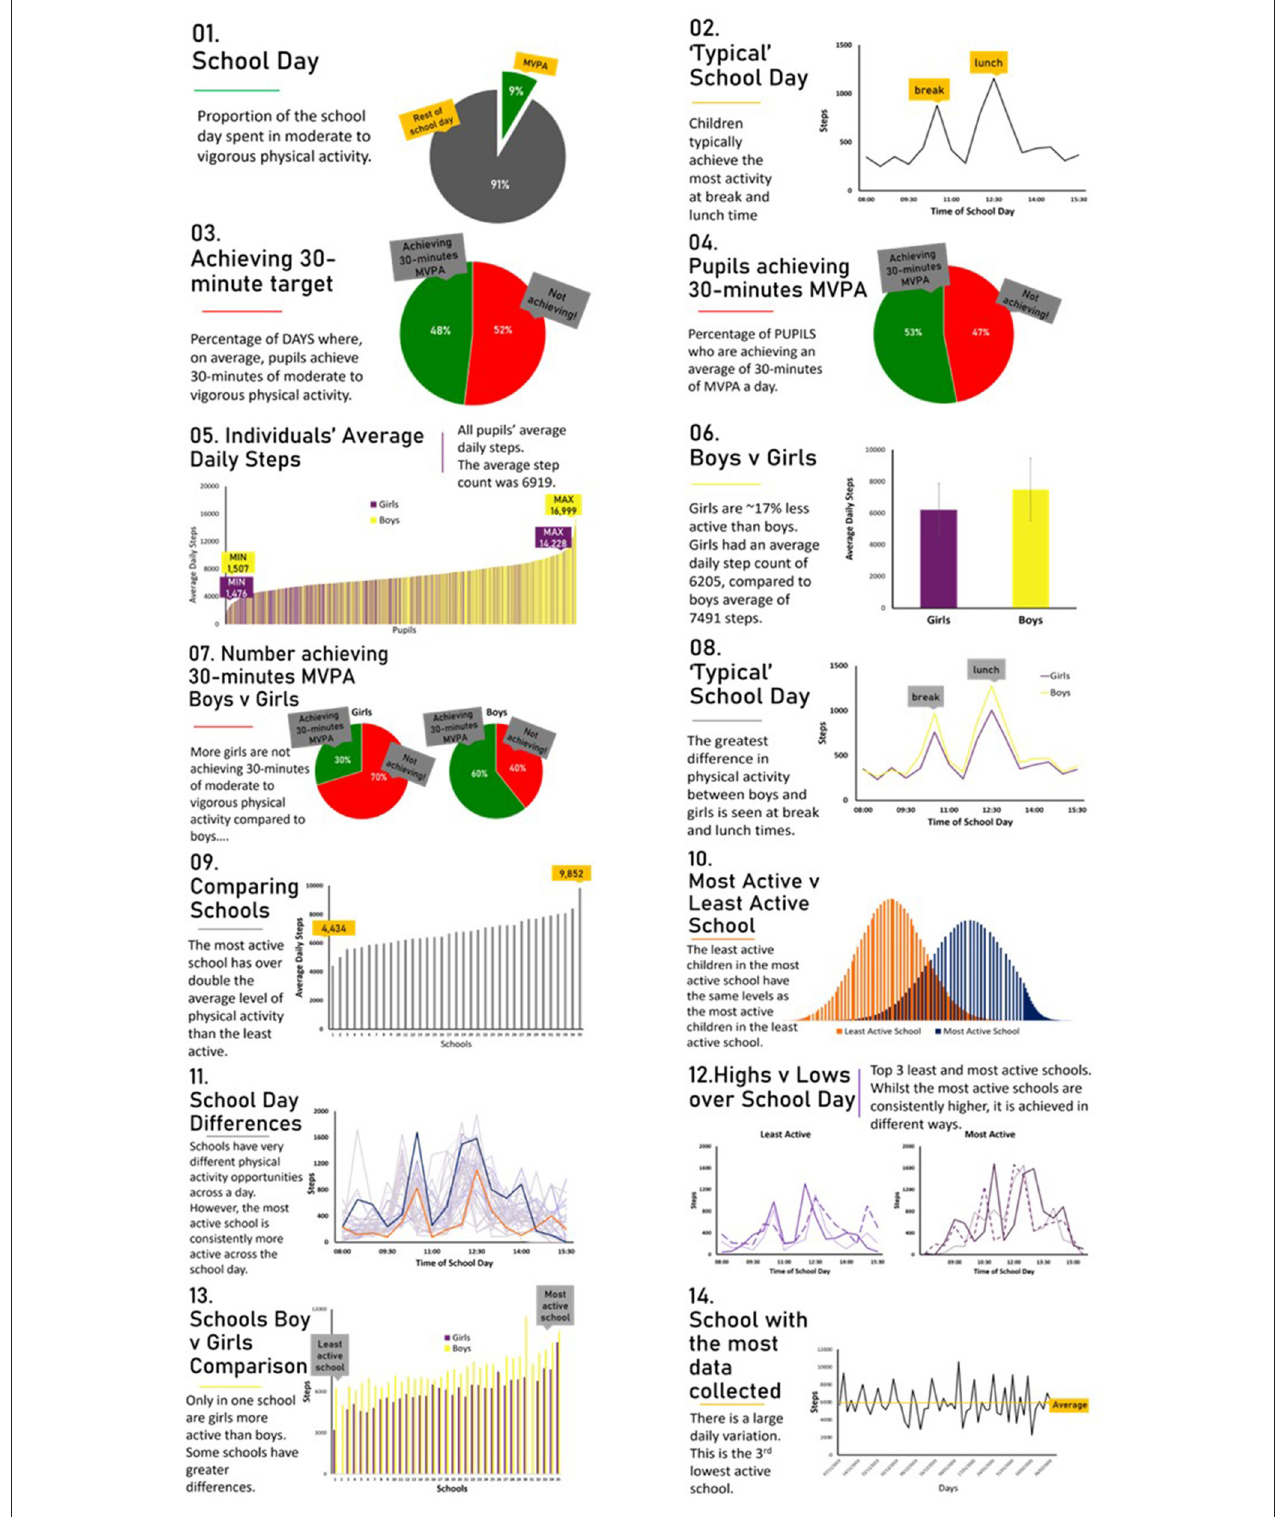
FIGURE 1 | Graphs shown to teachers during semi-structured interviews. *Please note data in graph 4 should be presented the other way round, with 47% of pupils achieving MVPA target.